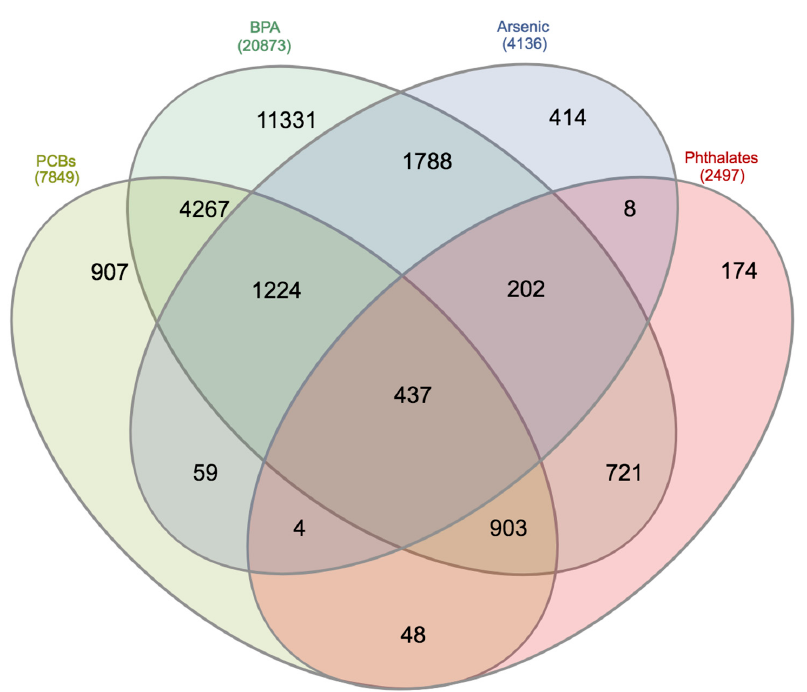
Figure 1. Venn diagram showing the interacting genes between estrogenic endocrine disruptors (EEDs): Polychlorinated biphenyls (PCBs; 7849 genes), Bisphenol A (BPA; 20873 genes), Arsenic (4136 genes), and Phthalates (2497 genes). Results show 437 overlapping genes.